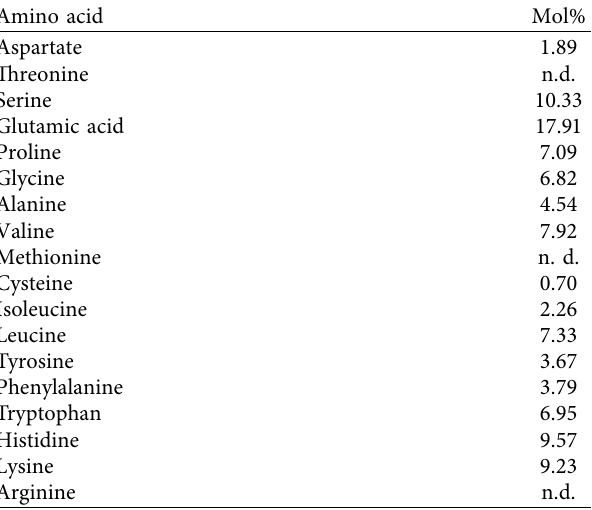
Figure 6: Monosaccharide standard (a) and monosaccharide composition of LML (b) (the peaks represent rhamnose (1), arabinose (2), xylose (3), mannose (4), glucose (5), and galactose (6) in the above figure). Table 3: Amino acid composition of